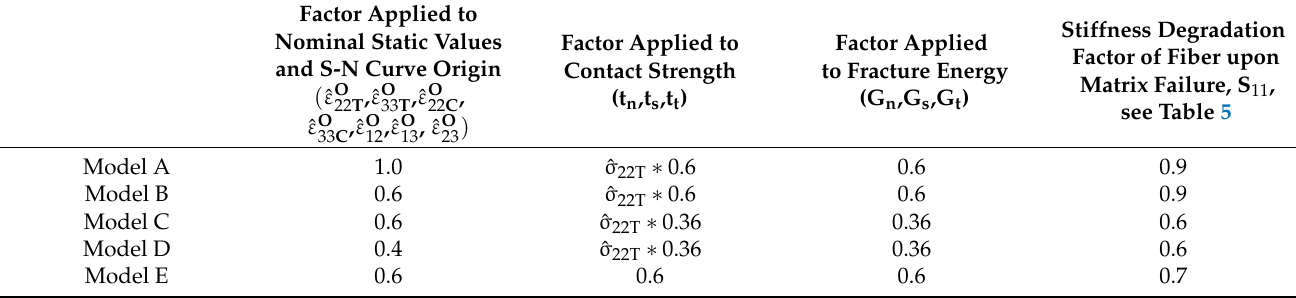
Table 4. Parameters for Models A to D for FEA simulations.